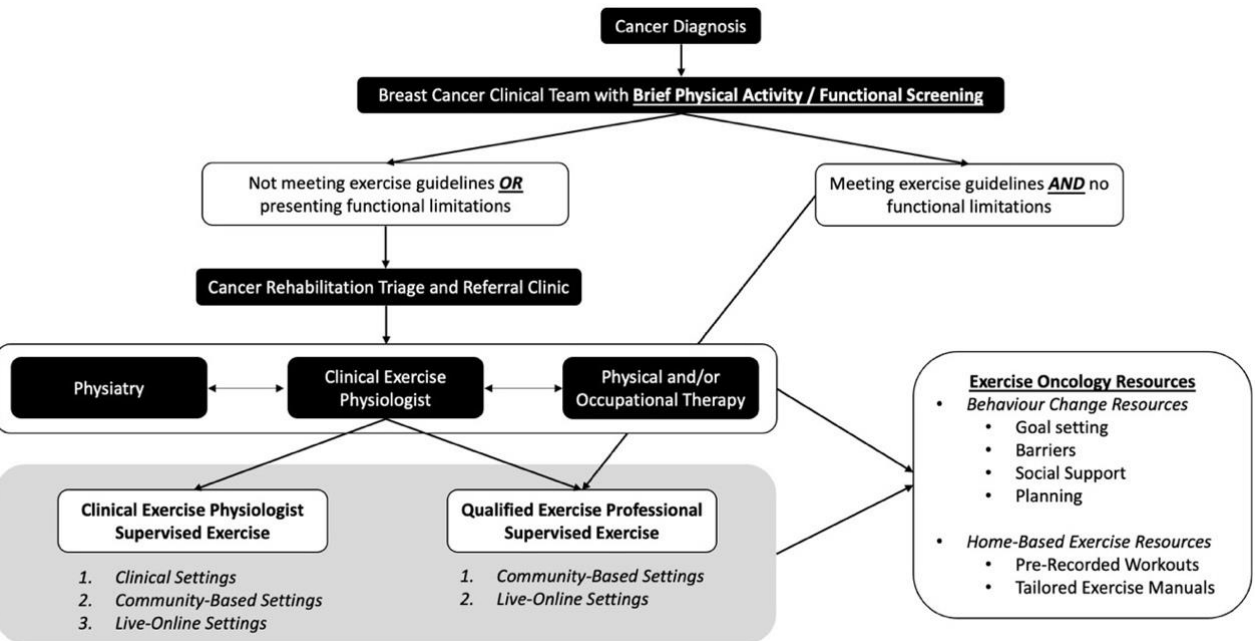
Figure 1. Breast Cancer Pathway for Integration of Exercise Oncology: Screening, Triage, and Re- ferral.